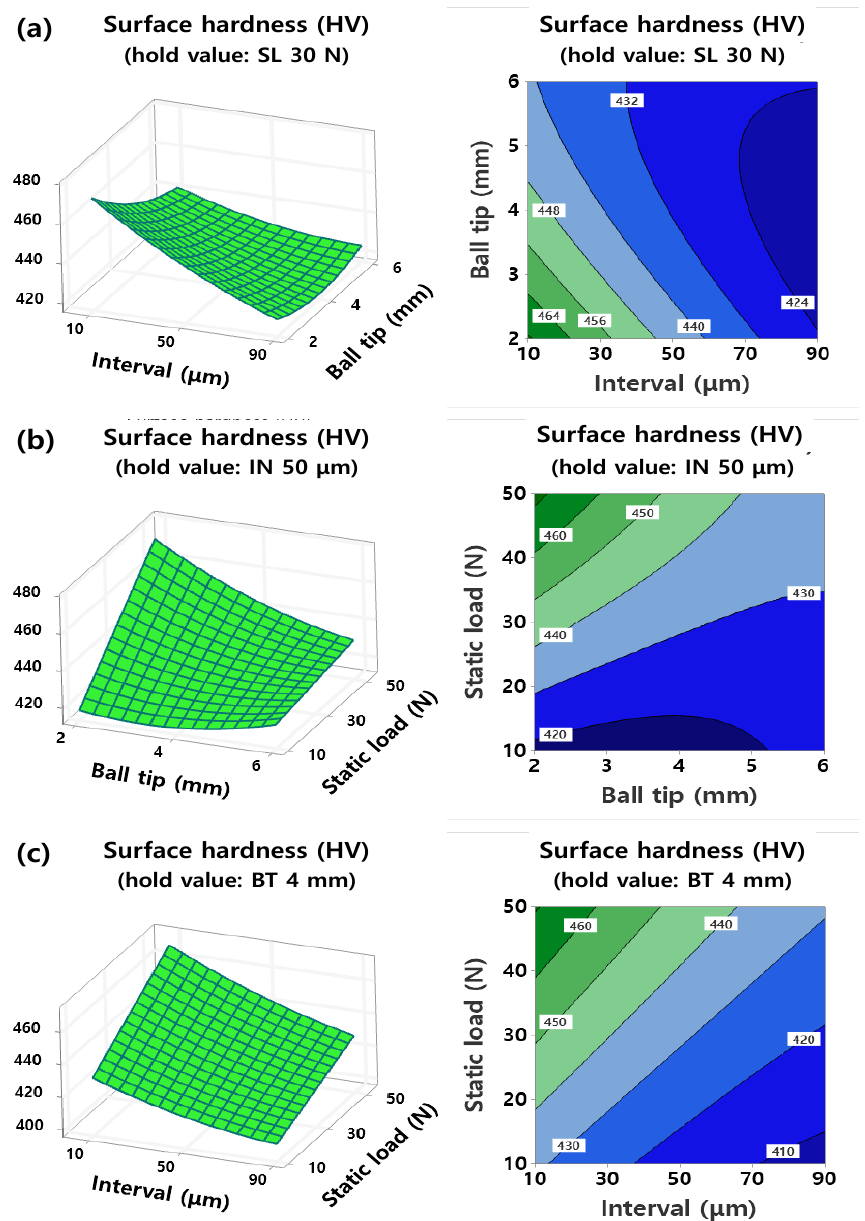
Figure 8. RSM results for hardness between ( a ) inter-pass interval and ball tip diameter, ( b ) load and ball tip diameter, and ( c ) load and inter-pass interval.